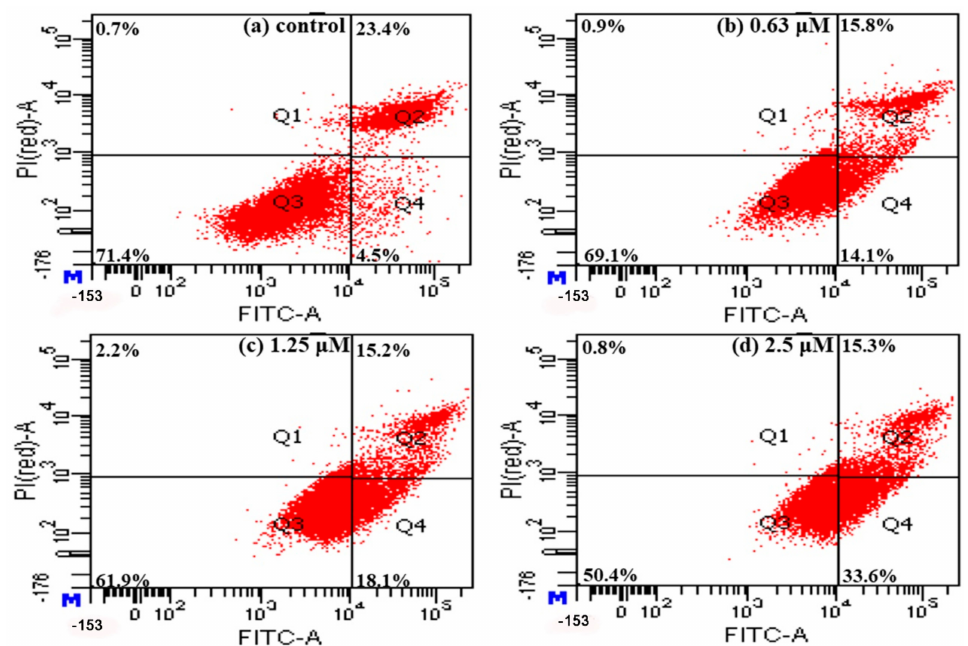
Figure 6. Flow cytometry analysis for apoptosis of LNCaP-FGC cells (high expression of PSMA) induced by CPT-HT-J-ZL 12 : ( a ) control group; ( b ) 0.63 µ M; ( c ) 1.25 µ M; and ( d ) 2.5 µ M.